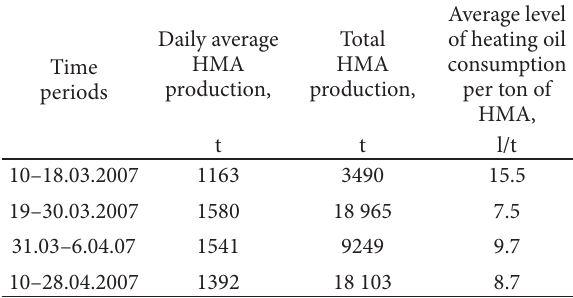
Table 4 . Fuel consumption in litres of fuel per ton of the produced HMA in 2007 Daily average HMA Time periods